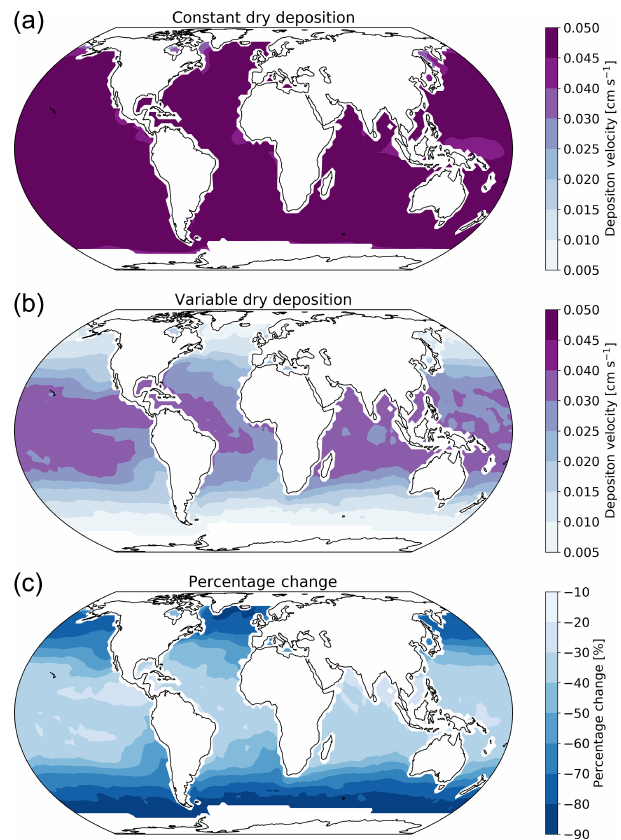
Figure 2. Annual average ozone deposition velocities for 2014 as calculated by GEOS-Chem using the default deposition scheme (a) , the new parameterization (b) and the percentage change between the two schemes (c) . A 2 ◦ × 2 . 5 ◦ land mask has been applied to the deposition velocities to show only the deposition velocity to the